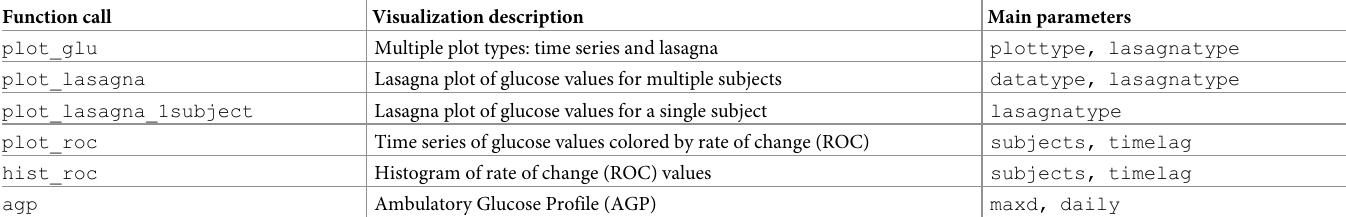
Table 4. Summary of iglu visualization